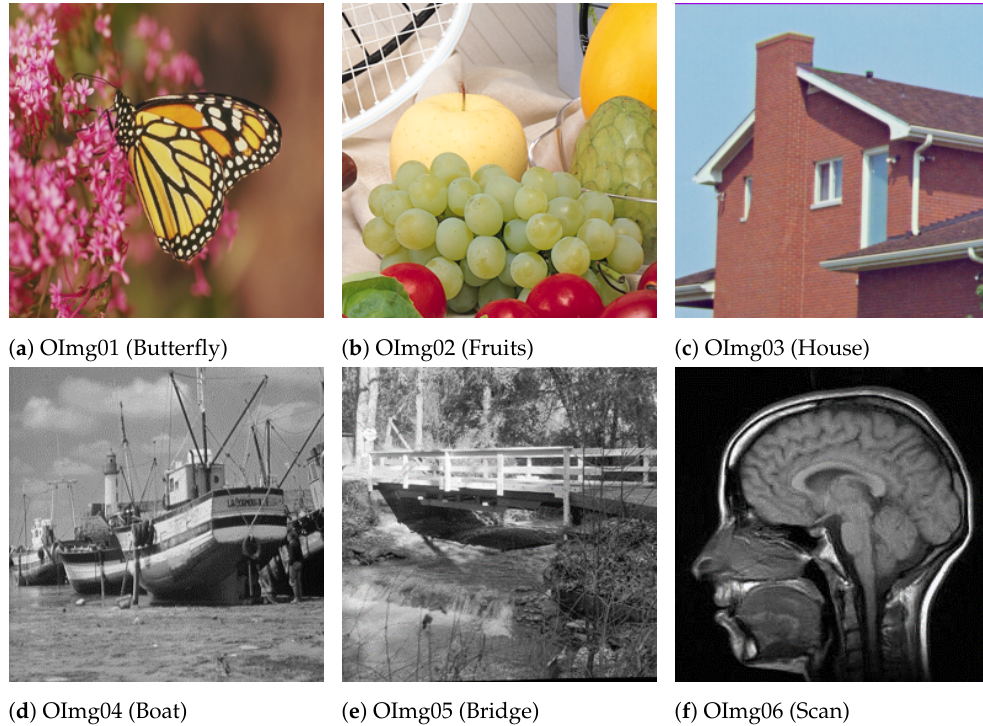
Figure 3. Original images ( a – f ) each of size 256 × 256 used to validate the proposed scheme.